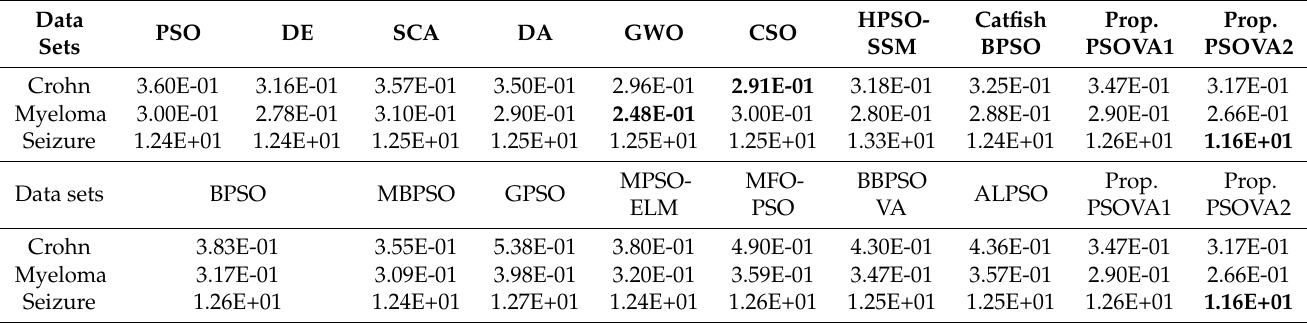
Table 9. The mean training computational costs over a set of 30 runs (in seconds).